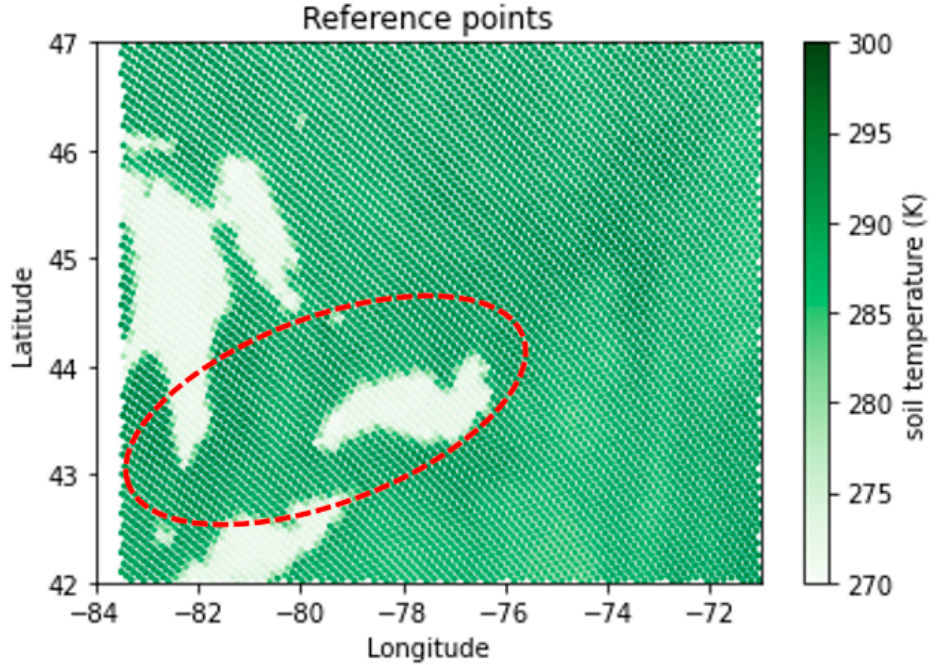
Figure 2. Graphical demonstration of gridded values of soil temperature in the study area, reported by Environment and Climate Change Canada (dashed circle shows the area of interest).